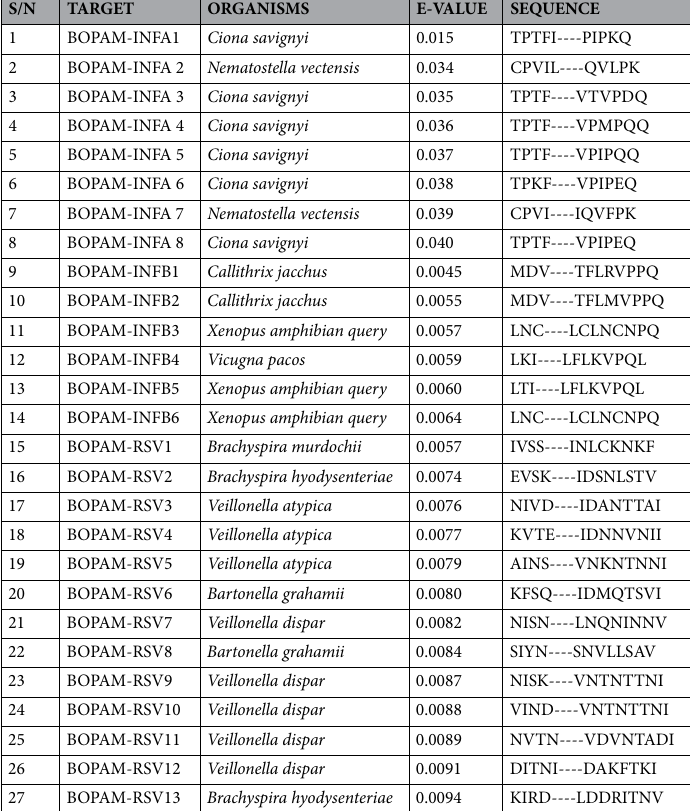
Table 4. Final list of the Anti-bacteria and Anti-viral pneumonia AMPs with their sources. BOPAM-INFA1-13 putative anti-Influenza A virus AMP, BOPAM-INFB1-7 putative anti-Influenza B virus AMP, BOPAM-RSV1-13 putative anti-Respiratory Syncytial Virus AMP. “-” represents the coded amino acid residues that are available subject to